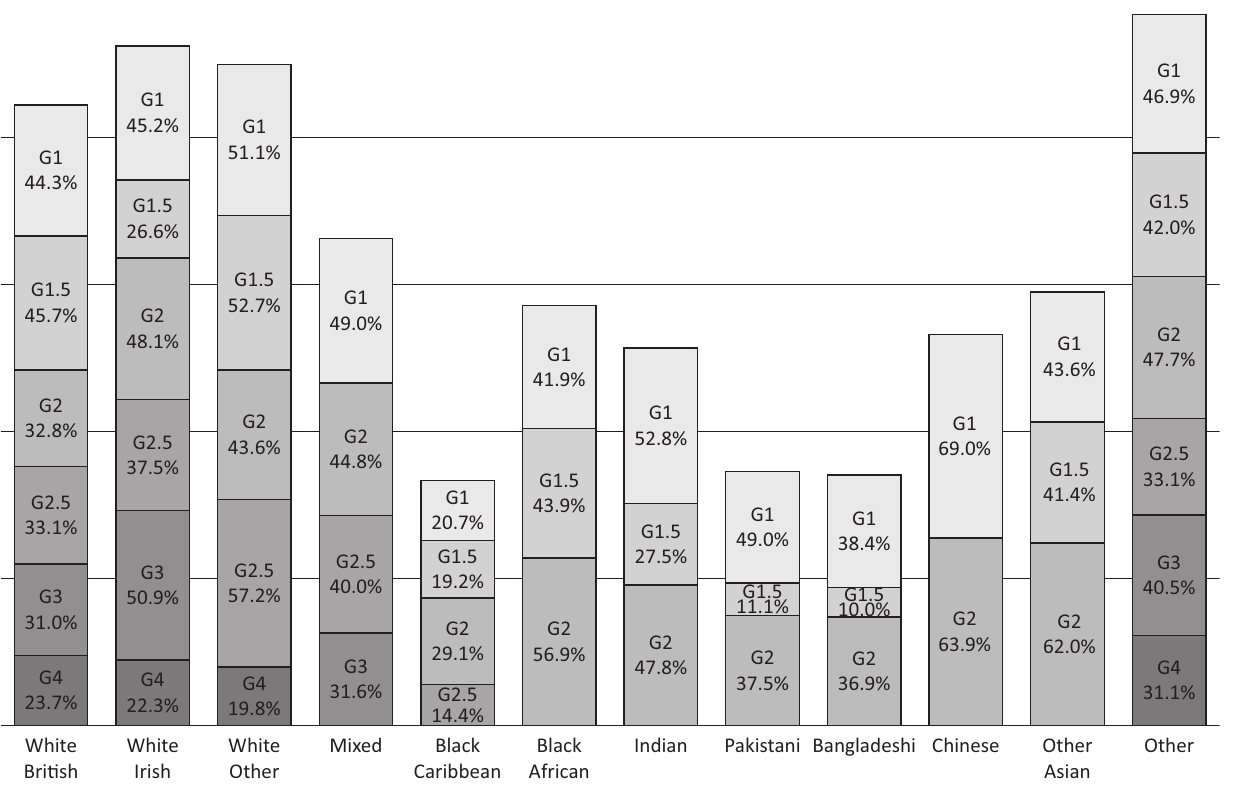
Figure 1. Degree-level attainment by ethno-generational status. Source: Understanding